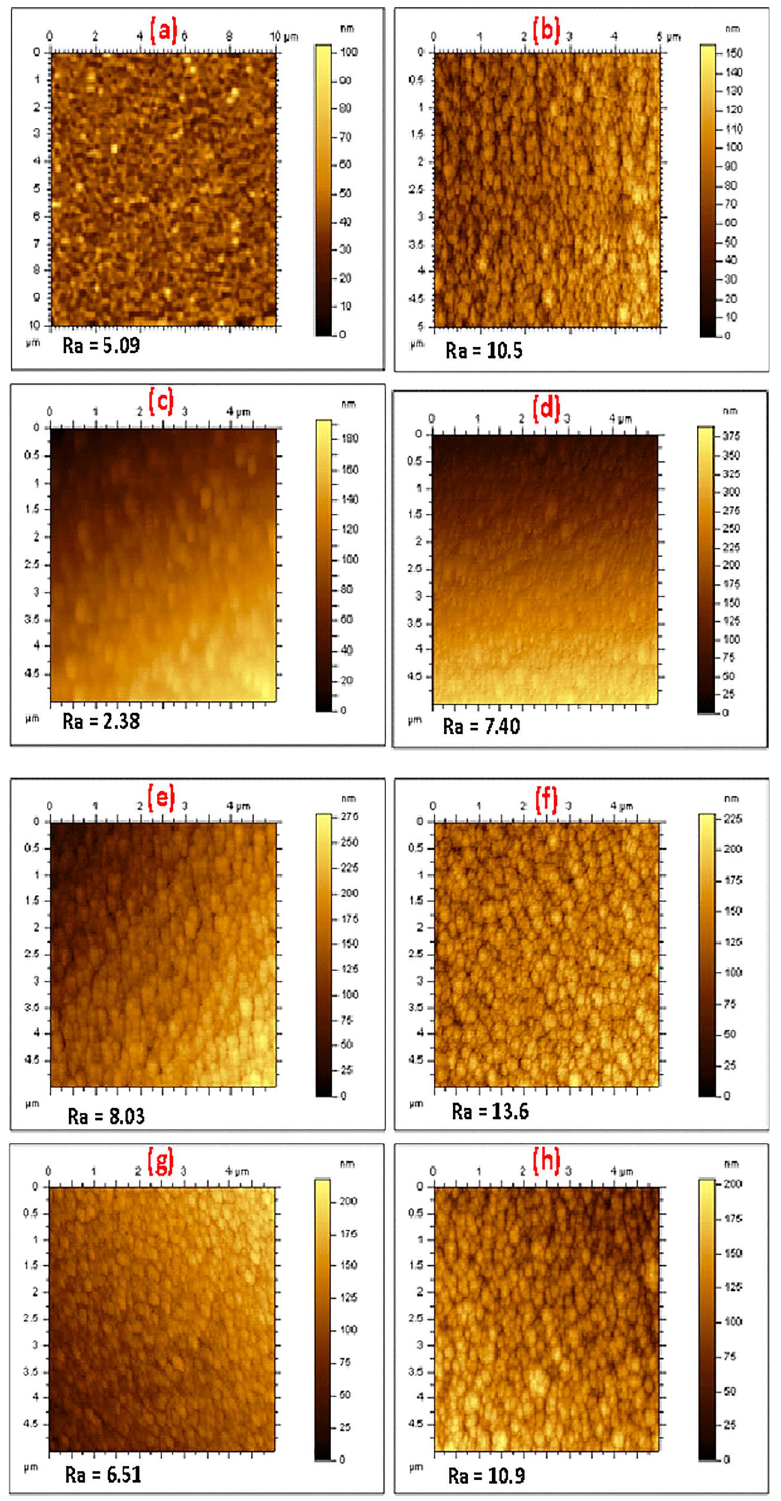
Figure 10. 2D AFM images obtained from the top surfaces (5 × 5 µm area) of (a) PN7, (b) PN8, (c) PN9, (d) PN10, (e) PN11, (f) PN12, (g) PN13, (h) PN14 multilayer coatings. The quoted Ra value for each coating is the average of Ra values obtained at 11 different points across the 5 × 5 µm